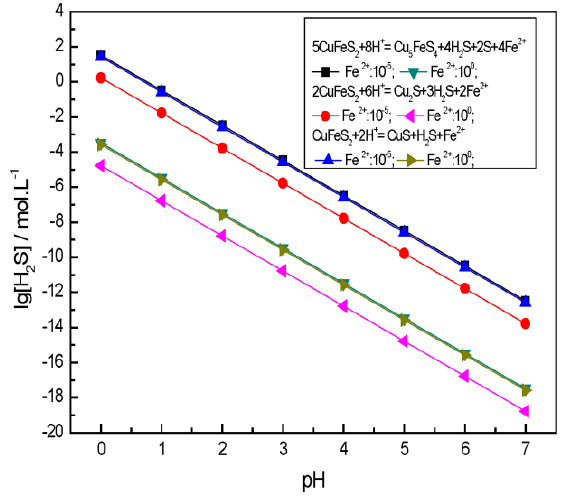
Figure 3. Equilibrated H 2 S concentration for acid dissolution of CuFeS 2 in different reactions.